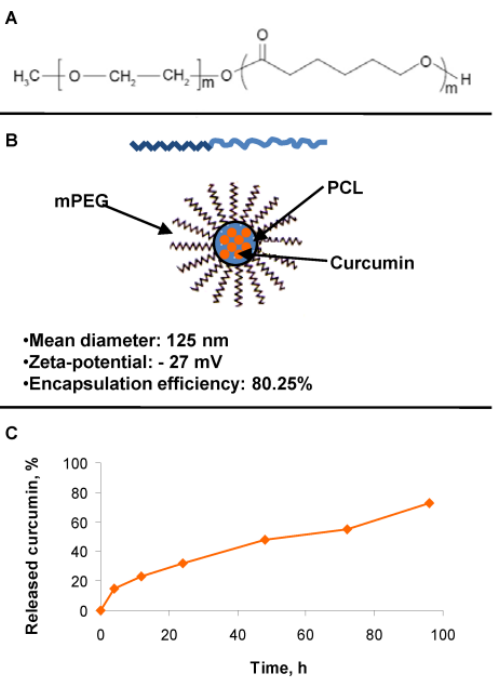
Figure 2. Structure of the micelles and achievement of sustained release with slightly pronounced burst release of curcumin. Legend : ( A )—Copolymer carrier mPEG-PCL; ( B )—curcumin loaded mPEG-PCL micelles and their physicochemical properties; ( C )—curcumin release from the loaded mPEG-PCL micelles. Table 1. Extracellular concentration of MCRM in comparison to pure curcumin after treatment of HuT-78 cells.